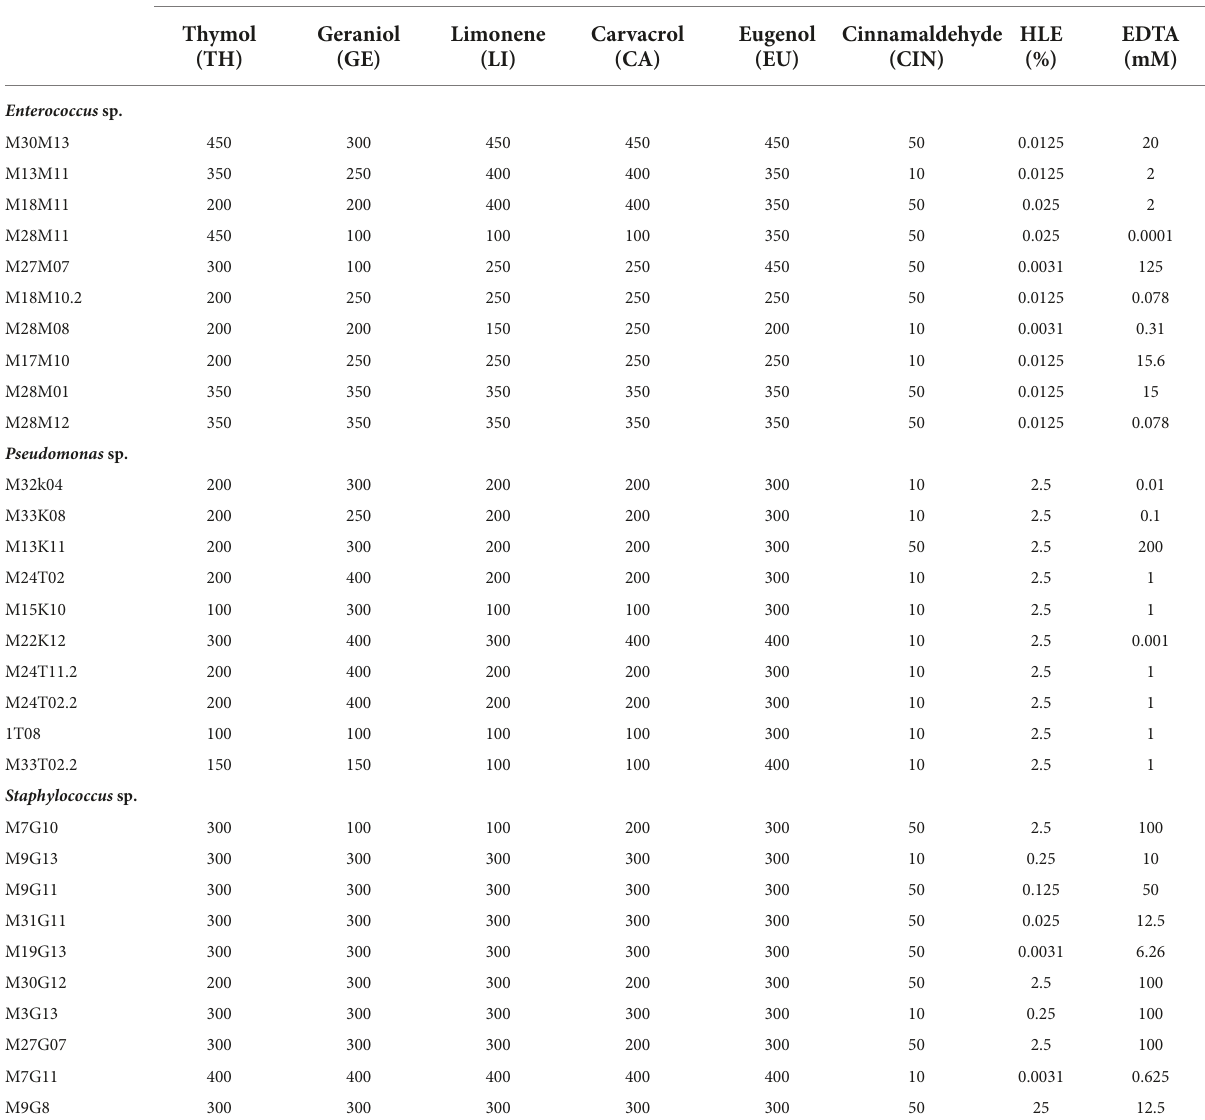
TABLE 4 MIC of EOCs, HLE and EDTA against Enterococcus sp., Staphylococcus sp. and Pseudomonas sp. strains isolated throughout meat chain production in a lamb and goat slaughterhouse of Jaén. Bacteria Antimicrobials ( µ g/mL) Thymol Geraniol Limonene (TH) (GE) (LI) Enterococcus sp.